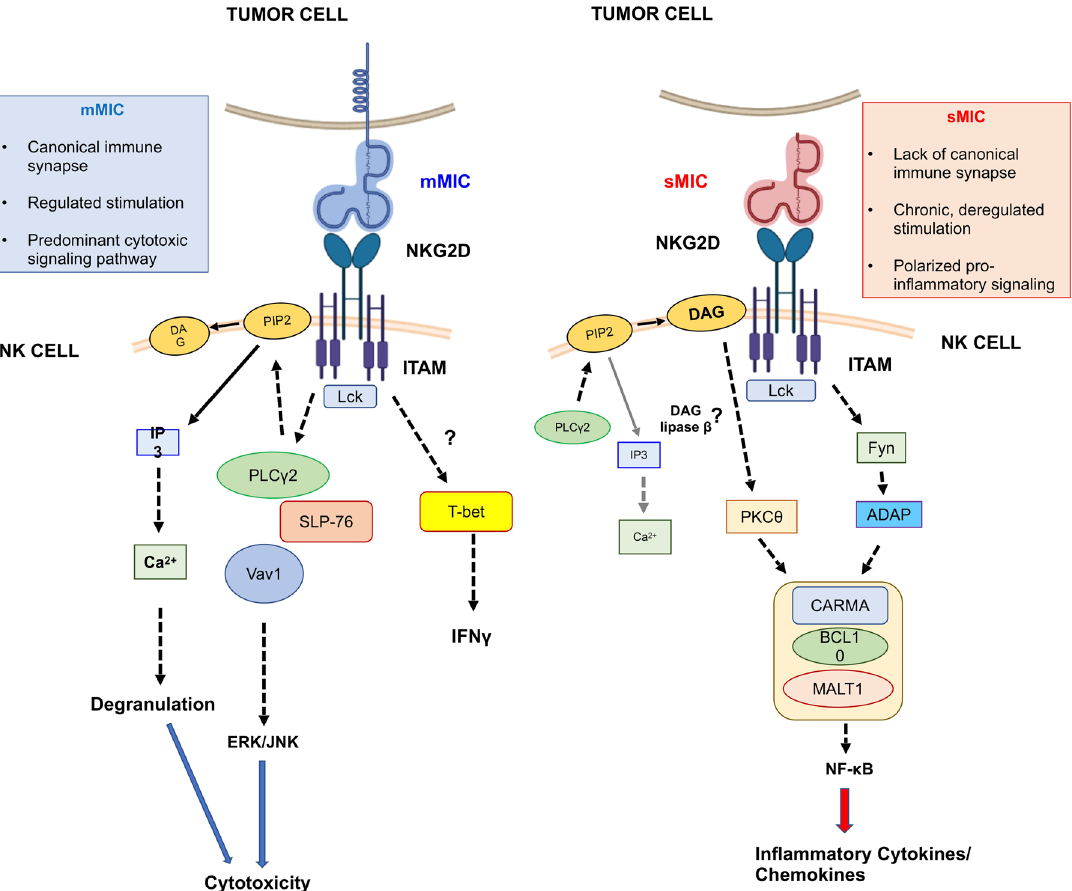
Fig. 8 Proposed model of the molecular pathways whereby mMIC and sMIC differentially regulate NK cell function. Engagement of the receptor NKG2D to the two forms of MIC ligand, mMIC, and sMIC leads to distinct signaling cascades resulting in activation of NK cell cytotoxicity and in fl ammatory cytokine/chemokine production, respectively. mMIC-NKG2D interaction delivers a regulated stimulation through canonical immune synapse formation and selectively activates PLC γ 2/SLP-76/Vav-1 and ERK/JNK signaling axis for NK cell cytotoxicity and upregulation of T-bet for IFN γ secretion. Conversely, the lack of canonical immune synapse formation upon sMIC-NKG2D interaction delivers a chronic and deregulated stimulation that results in activation of CBM-signalosome-mediated pro-in fl ammatory pathways. The activation of CBM-signalosome pathways is associated with persistent activation of Fyn/ADAP and PKC- θ pathways. The ITAM immediate downstream molecule Lck is required for both mMIC- and sMIC-stimulated was >85%. Cells were loaded to 10× chromium machine (10× genomics), in which the library preparation procedure was conducted according to the standard pro- tocol of the Chromium single-cell 3 ’ kit, V3 chemistry. Sequencing was performed on Hi-Seq 4000 system (Illumina, 100-bp paired-end protocol). The kallisto | bustools (kallisto v0.46.0 and bustools v0.39.1) work fl ow was used to pre-process the single-cell RNA-seq un fi ltered feature-barcode matrix generated method implemented in DropletUtils R package was applied to detect and remove empty droplets 75 . The data analysis was performed using the Seurat R package on the UMI count gene-by-cell matrix 76 . Low-quality cells were fi ltered out if meeting one of the following criteria: (1) with genes detected in less than three cells; (2) with less than 200 genes expressed; (3) with >3 standard deviations above the mean number of genes detected; (4) with >5% of their UMI counts mapping to MT genes. The UMI counts were normalized using sctransform method 77 . Potential doublets were detected and removed with DoubletFinder R package 78 . Data integration using Harmony was performed to minimize the batch effects caused by the unwanted technical variations 79 . The highly variable genes were subsequently selected for principal component analysis (PCA). The fi rst 30 principal components of the z -normalized data were used for clustering cells using Seurat k - nearest neighbors clustering with resolution 1.6. Cell populations were identi fi ed for each cluster by examining the expression of marker genes and the top differentially expressed genes in each cluster. Cells were visualized by UMAP on the same 30 principal components. Cells from NK clusters were extracted and applied to the HIPPO method to identify NK cell subtypes 31 . MAST algorithm implemented in FindMarker function from Seurat package as applied to identify differentially expressed genes in NK cell subtypes between PD and WD tumors. Gene set enrichment analysis was performed using the functions implemented in